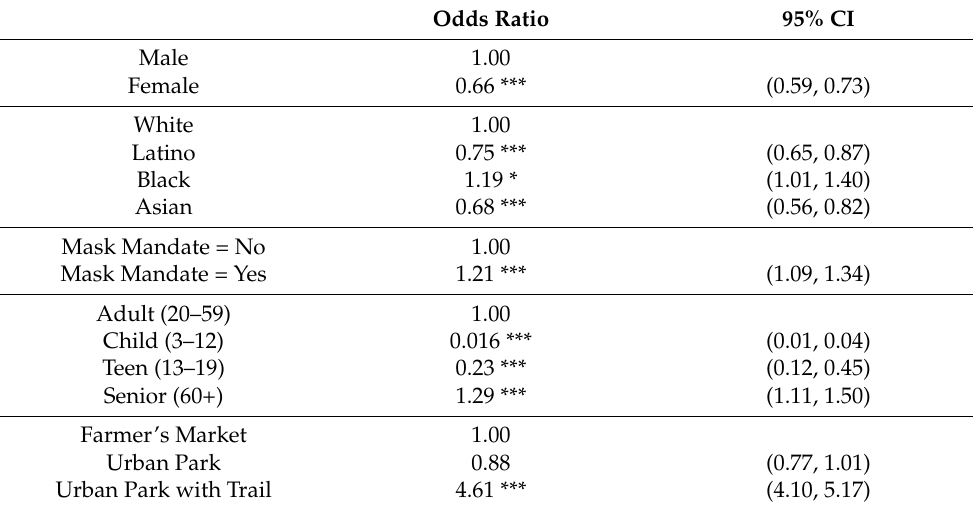
Table 4. Logistic regression estimates predicting social distancing behavior in response to COVID-19, Houston, TX, January to April